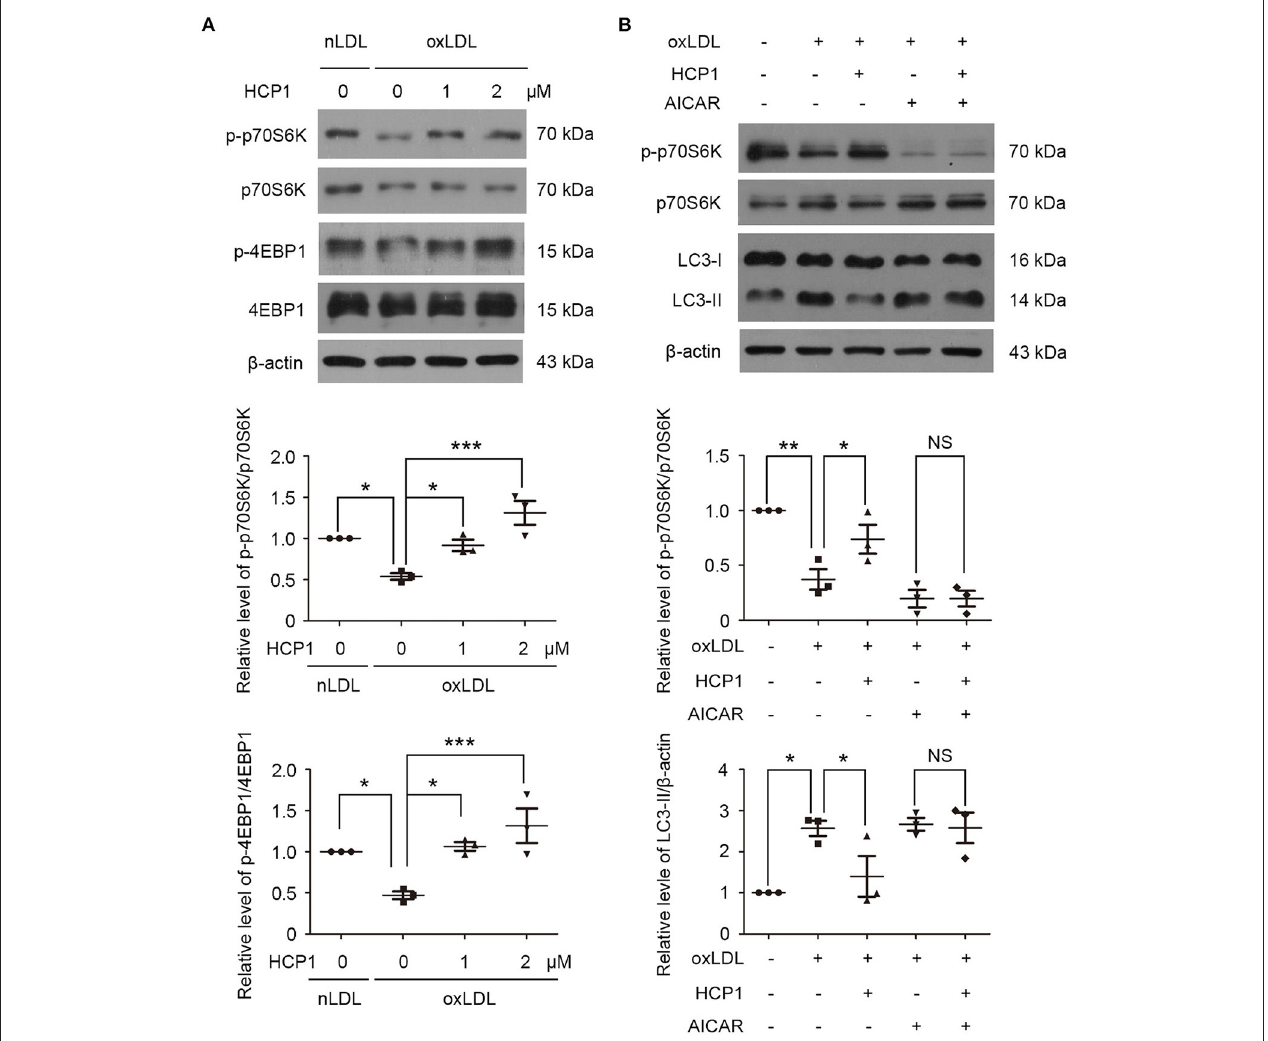
FIGURE 4 | HCP1 activated mTORC1 activity and reduced LC3-II protein level through inhibiting AMPK. (A) Protein levels of phosphorylated p70S6K (p-p70S6K, Thr389), total p70S6K, phosphorylated 4EBP1 (p-4EBP1, Thr37/46), and total 4EBP1 in HUVECs treated with nLDL (50 µ g/ml), oxLDL (50 µ g/ml) with or without HCP1 (1, 2 µ M) for 12h. Bar charts show quantification of the ratios of p-p70S6K to total p70S6K and p-4EBP1 to total 4EBP1. (B) Protein levels of phosphorylated p70S6K (p-p70S6K, Thr389), total p70S6K, and LC3-II in HUVECs treated with nLDL (50 µ g/ml), oxLDL (50 µ g/ml) with or without HCP1 (1 µ M), AICAR (5mM) for 12h. Bar charts show quantification of the ratios of p-p70S6K to total p70S6K and protein levels of LC3-II. Data are mean ± SEM; * p < 0.05, ** p < 0.01, *** p < 0.001, NS p > 0.05; n = 3. Statistical analyses were performed using one-way